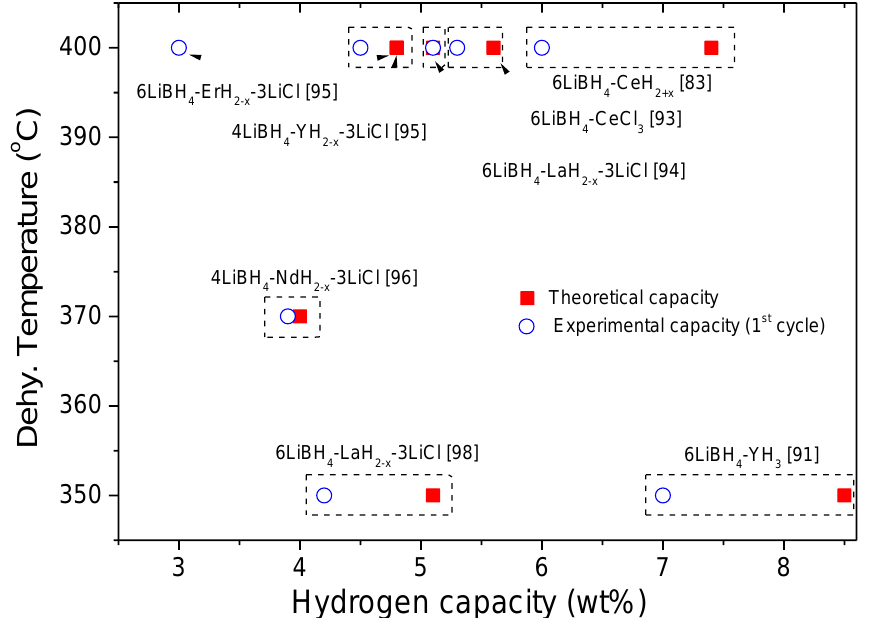
Figure 8. Experimental dehydrogenation temperatures vs. theoretical and experimental capacities of the LiBH 4 -RE hydride system.